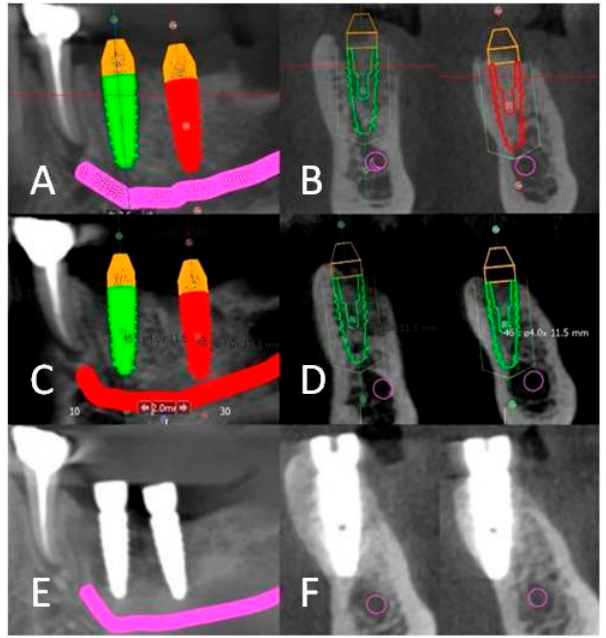
Figure 6. Surgical implant simulation with Immediateload Universe 4 × 11.5 mm implants ( A , B ) immediately after bone augmentation and ( C , D ) after four months of bone augmentation; ( E , F ) implant placement after eight months of bone augmentation.